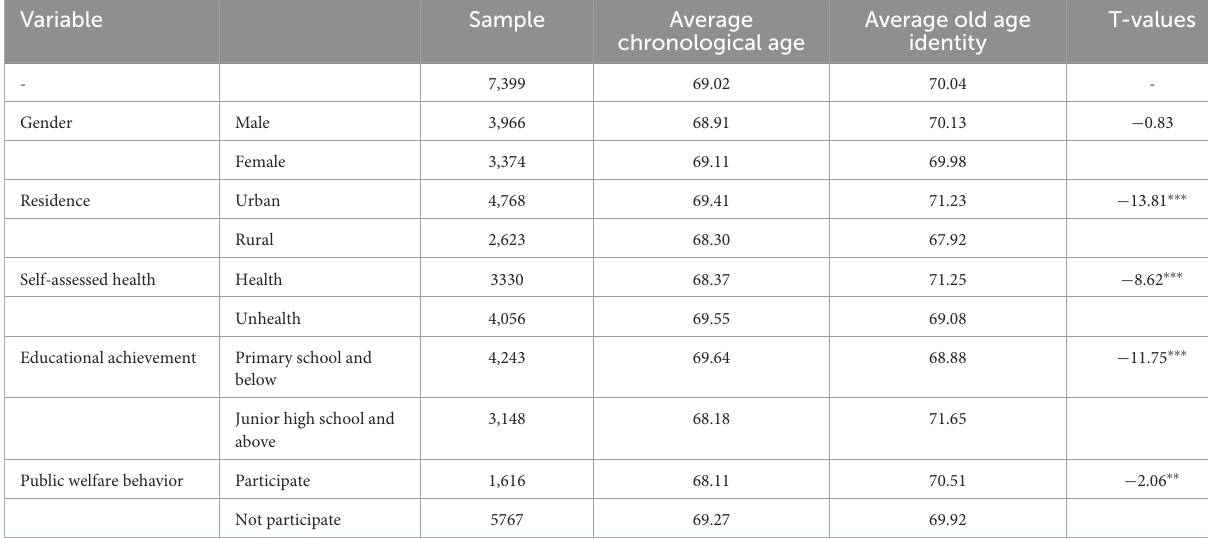
TABLE 2 The old age identity of the Chinese elderly based on CLASS2014.